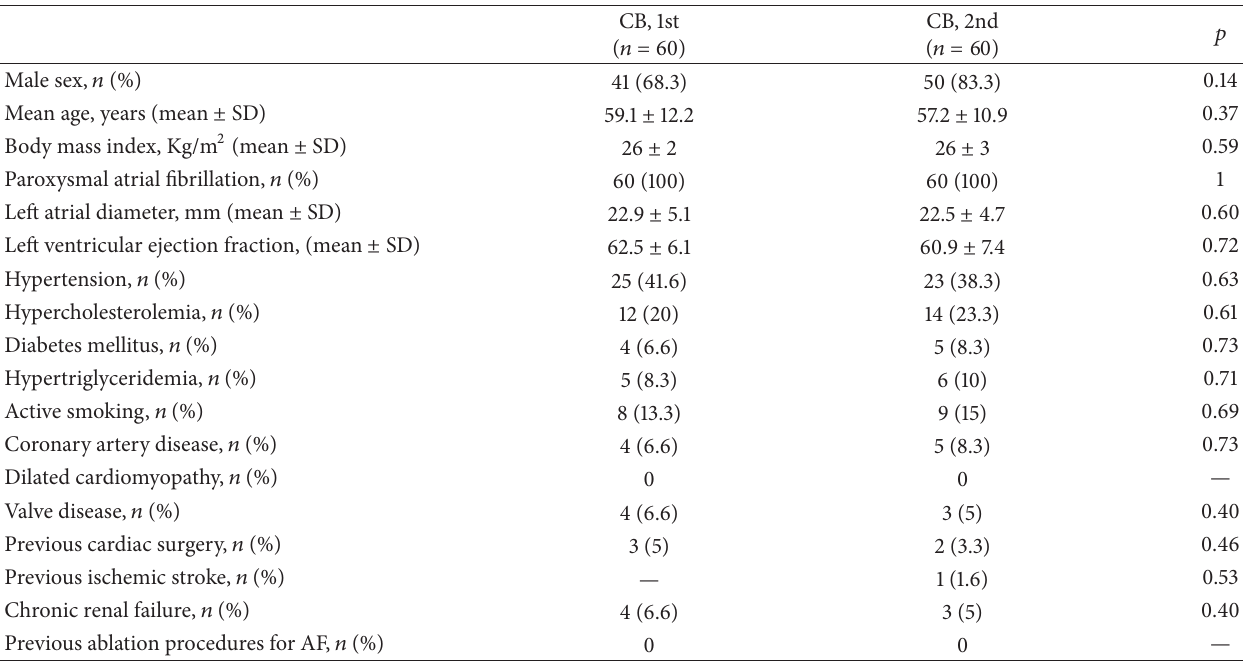
Table 1: Baseline patient characteristics.